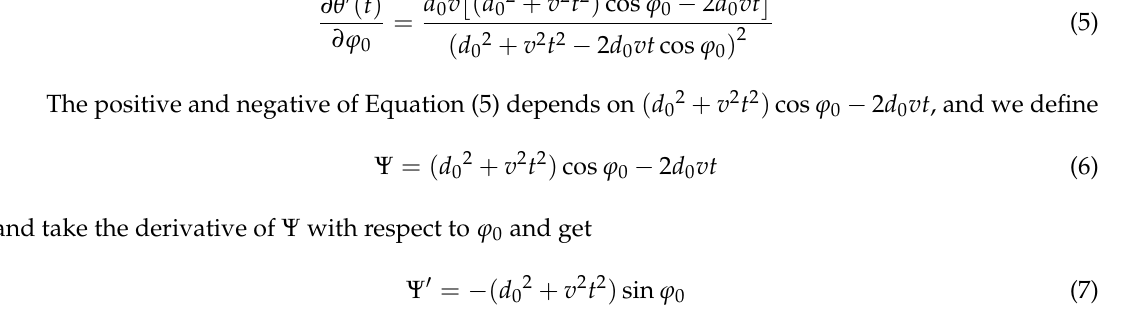
Figure 3. The change of the interference direction with the initial distance d 0 . ( a ) The change of the